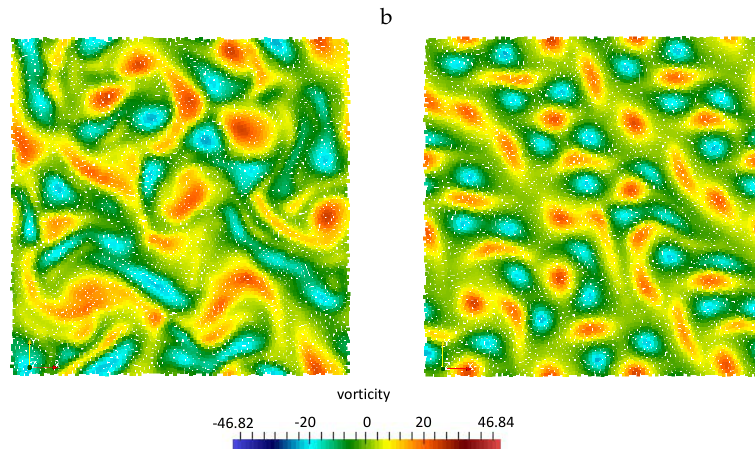
Figure 5. Inviscid two-dimensional Taylor–Green flow. Vorticity field for t = 2. Figure ( a ) shows the results using the δ + -SPH scheme with a constant value of α = 0.01. Figure ( b ) shows the results obtained using the δ + -LES-SPH approach. Results computed using a resolution of 10,000 particles.